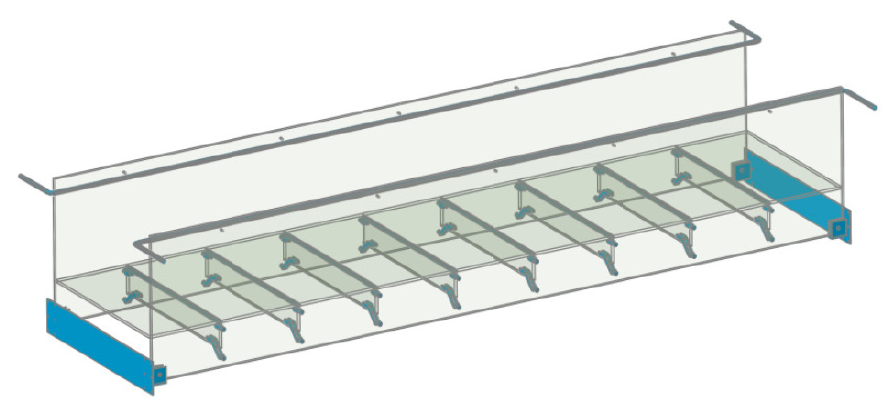
Figure 8: Glass bridge in the Ritz Carlton Hotel, Toronto